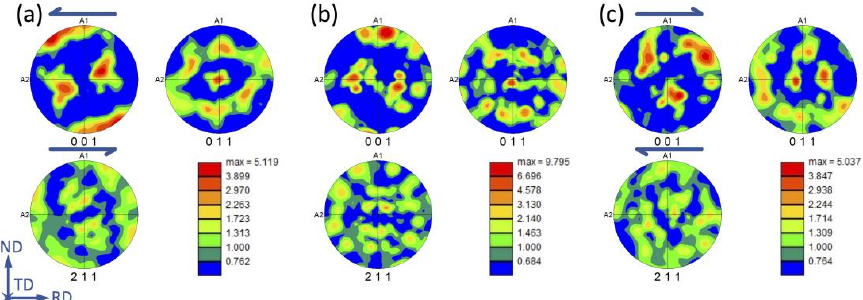
Figure 11. Pole figures projected on ND sample planes of R2 sample with ε = 1.00. ( a ) As-rolled sample. ( b ) Sample with post-rolling annealing at 850 °C for 0.5 h.